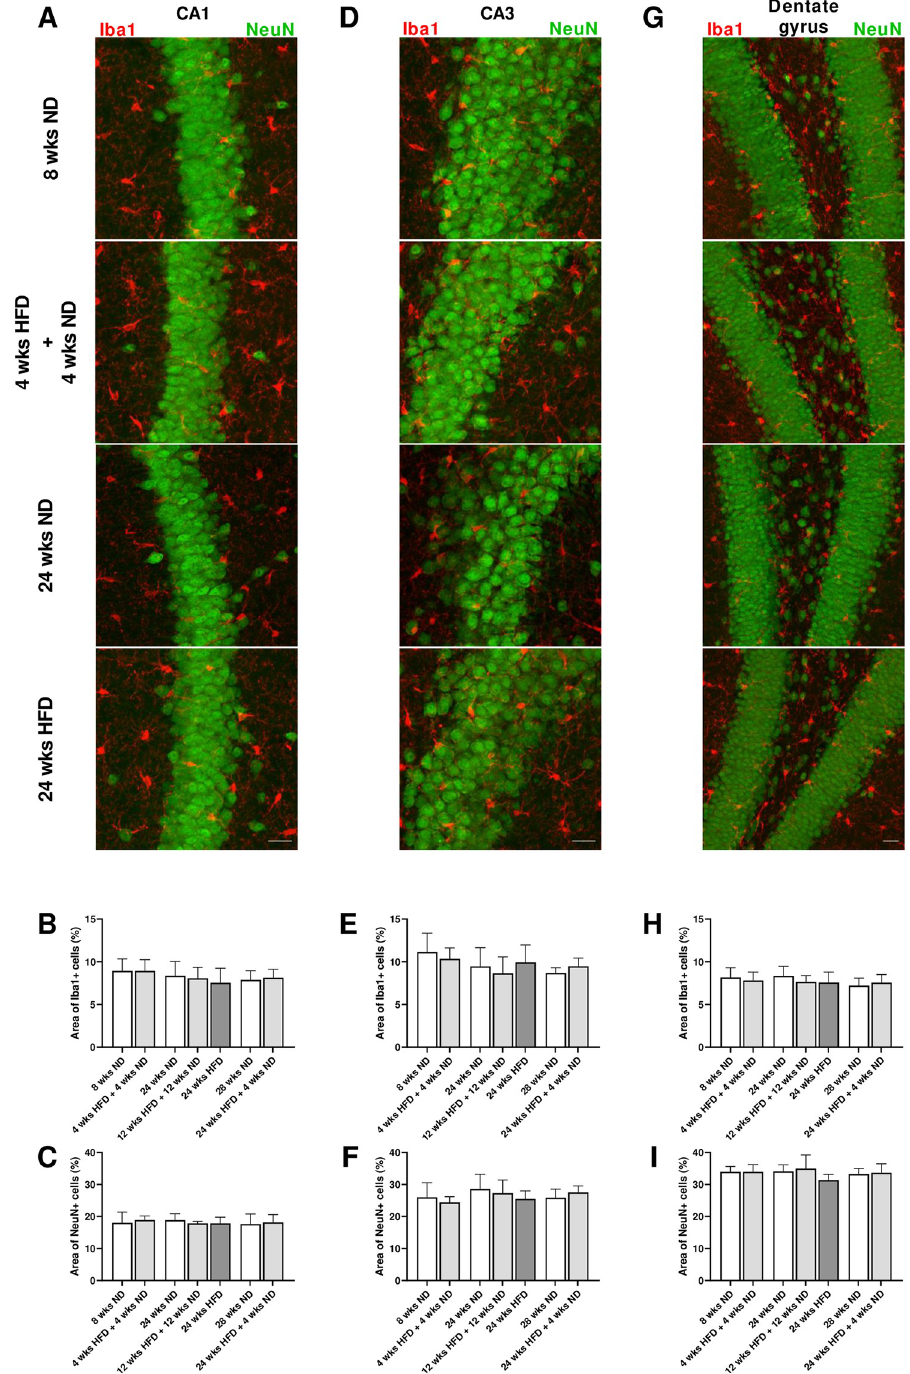
Fig 8. HFD-induced obesity does not alter hippocampal morphology. (A, D, G) Representative confocal images of double-labeled immunofluorescence staining for Iba1 (red) and NeuN (green) within the hippocampus, in particular CA1 and CA3 regions and dentate gyrus of male wild-type C57BL/6J mice fed with ND for eight wks, HFD for four wks followed by ND for four wks and ND or rather HFD for 24 wks. (B, E, H) Quantification of the area stained by Iba1 and (C, F, I) NeuN revealed no differences in hippocampal morphology in mice on HFD compared to ND-fed mice. Scale bar corresponds to 25 μ m. Data are presented as mean values and error bars indicate SD; 8 wks ND n = 6, 4 wks HFD + 4 wks ND n = 6, 24 wks ND n = 12, 12 wks HFD + 12 wks ND n = 6, 24 wks HFD n = 6, 28 wks ND n = 6, 24 wks HFD + 4 wks ND n = 6.